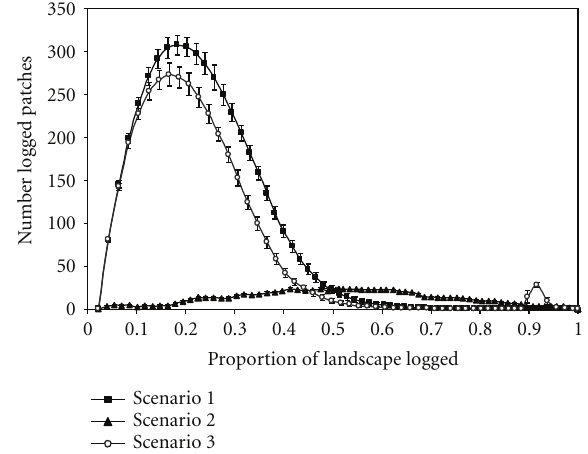
Figure 3: Number of logged forest patches over 80 years of selective logging simulations in a forest landscape (4225